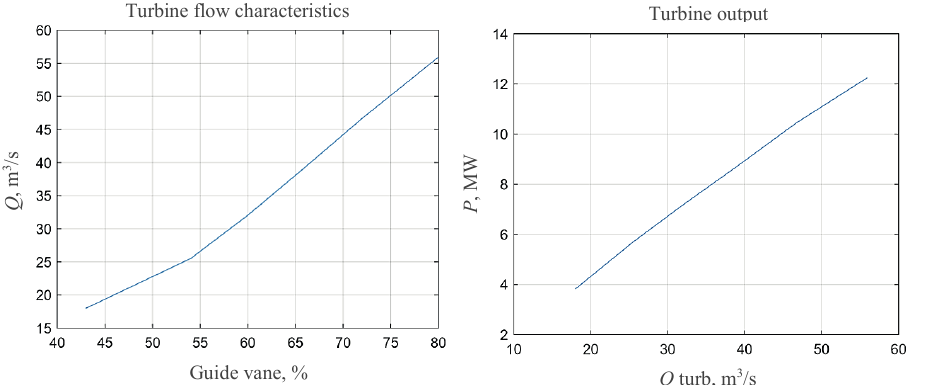
Fig. 2. Mass flow calculation from the turbine efficiency curve for nominal